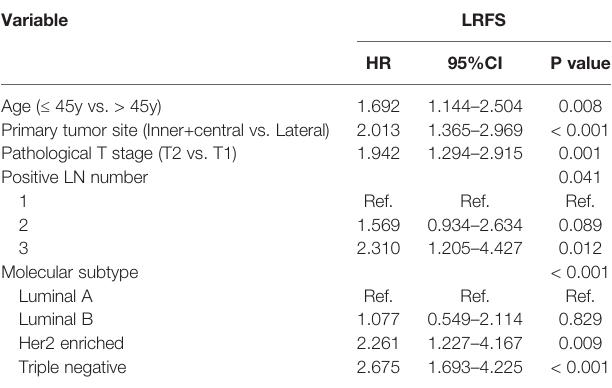
TABLE 2 | Univariate analysis of the association between clinicopathological features and locoregional recurrence-free survival (LRFS) for patients with pT1N1M0 breast cancer in the primary